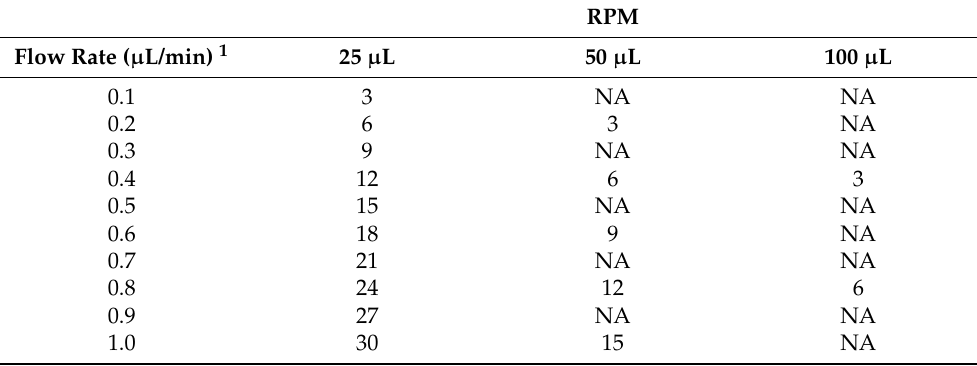
Table 2. The setting values of RPMs at various flow rates with three